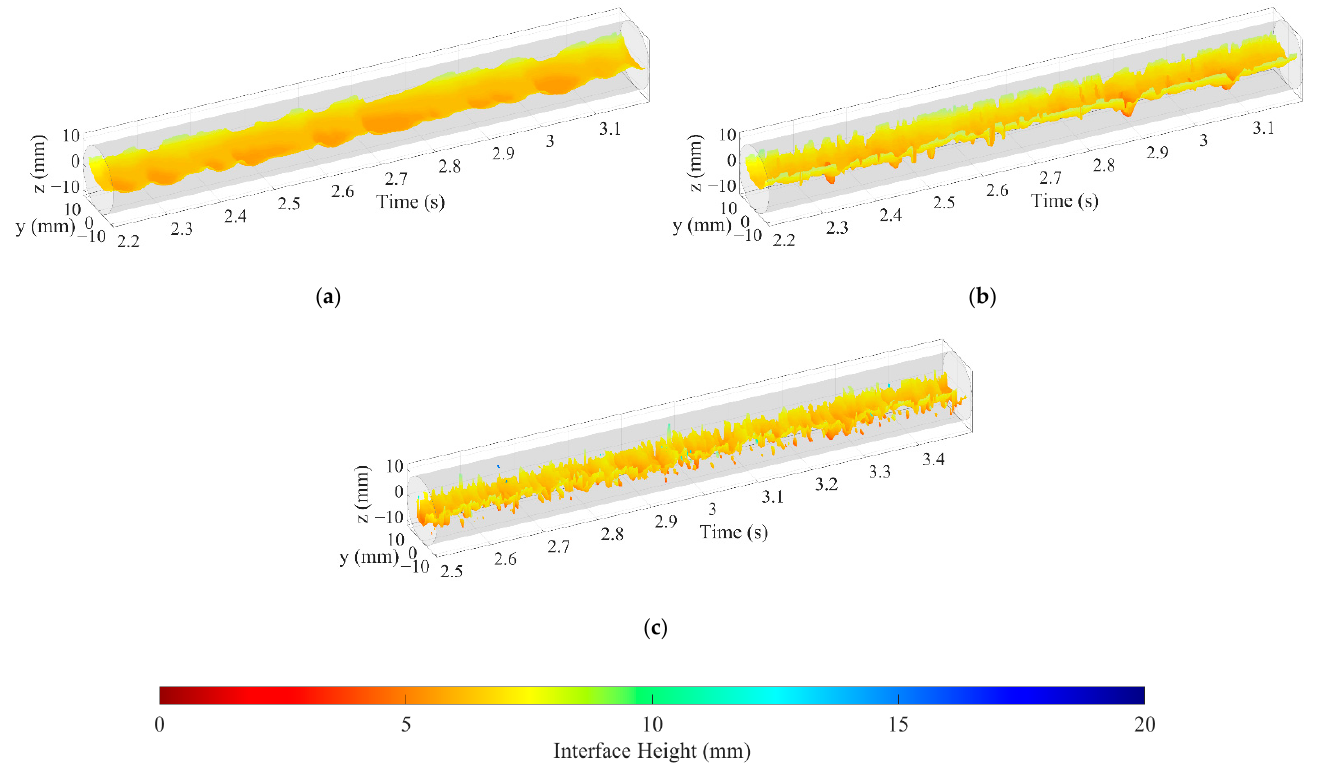
Figure 13. Extraction process of oil–water stratified interface and droplets: ( a ) Original normalized